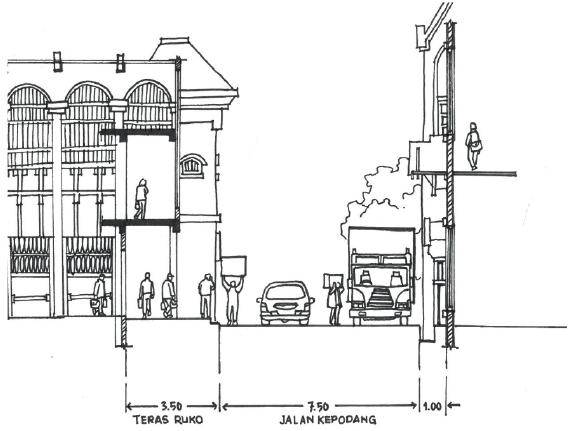
Fig. 8. The Building Facade Condition of The Social – Economic Trading Activities at Suari Street, Kota Lama